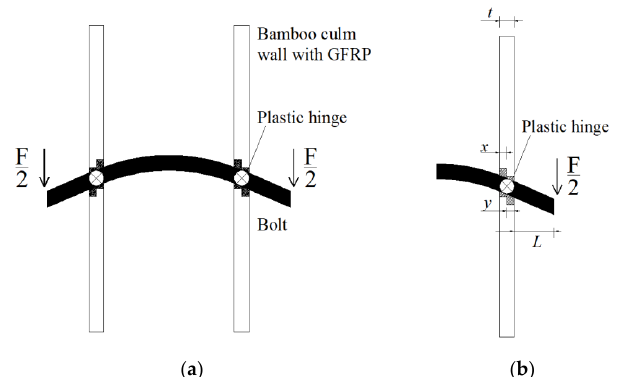
Figure 13. Load analysis mechanism of the composite joint. ( a ) Force diagram of the composite joint; ( b ) Semi-structural analysis diagram of the composite joint.